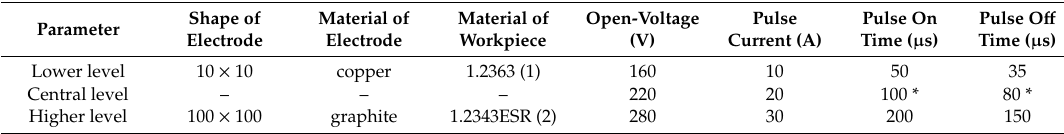
Table 1. Values of the input parameters for the design of experiments.